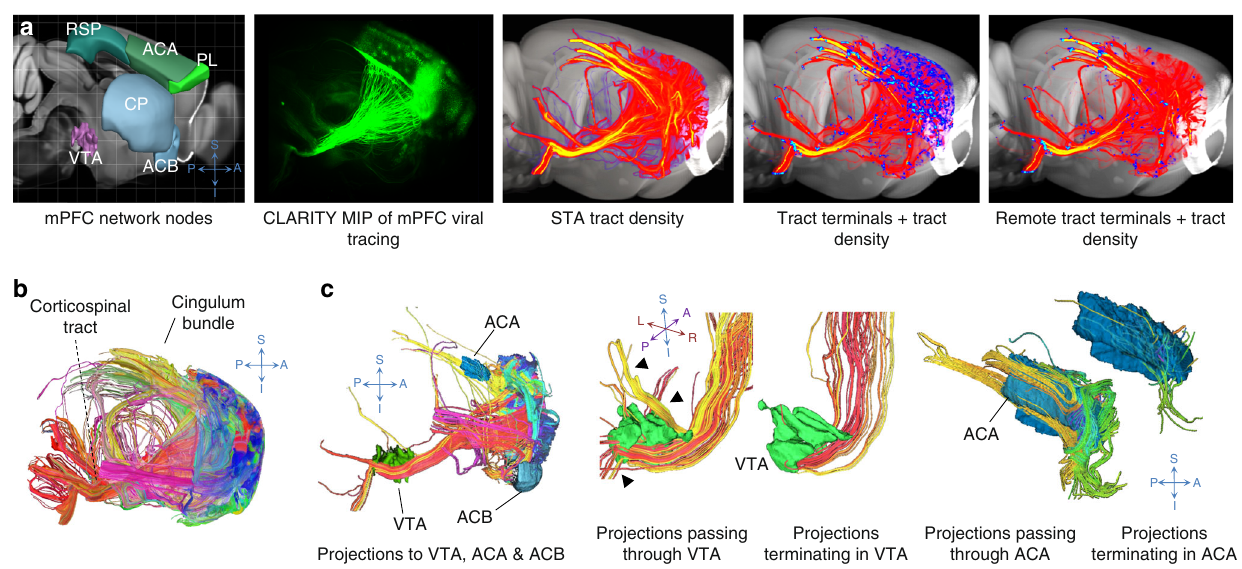
Fig. 6 Computing streamline terminal zones and connectivity graphs from CLARITY viral tracing. a Generation of the structure tensor analysis (STA)-based tract density and remote tract terminal maps. First panel: Anatomical locations of several nodes of the medial prefrontal cortex (mPFC) network. Second panel: Maximum intensity projection of an original CLARITY volume with an AAV tracing injection at the mPFC. Third panel: Tract density maps (red) of STA-based streamlines from a CLARITY volume registered to the ARA. Fourth panel: Tract terminals map (blue dots) from the same specimen, both overlaid over the 25 µ m ARA template and tract density map (red). Fifth panel: The same tract terminals map (blue dots) representing only terminals of long-range mPFC streamlines, with terminals near the injection site masked out, overlaid on the tract density map (red). b STA-based tractography of CLARITY viral tracing, colored by terminal location. c Depicting passing versus terminating mPFC tracts. mPFC streamlines to the ventral tegmental area (VTA), nucleus accumbens (ACB), and anterior cingulate area (ACA). Magni fi cations of passing versus terminating fi bers in the VTA and ACA show more fi bers terminate in the VTA than in the (Supplementary Fig. 9a, middle panel), with the graph represent- ing projection density from the PL area of the Allen connectivity atlas (Supplementary Fig. 9a, left panel). An overlap of 74% was